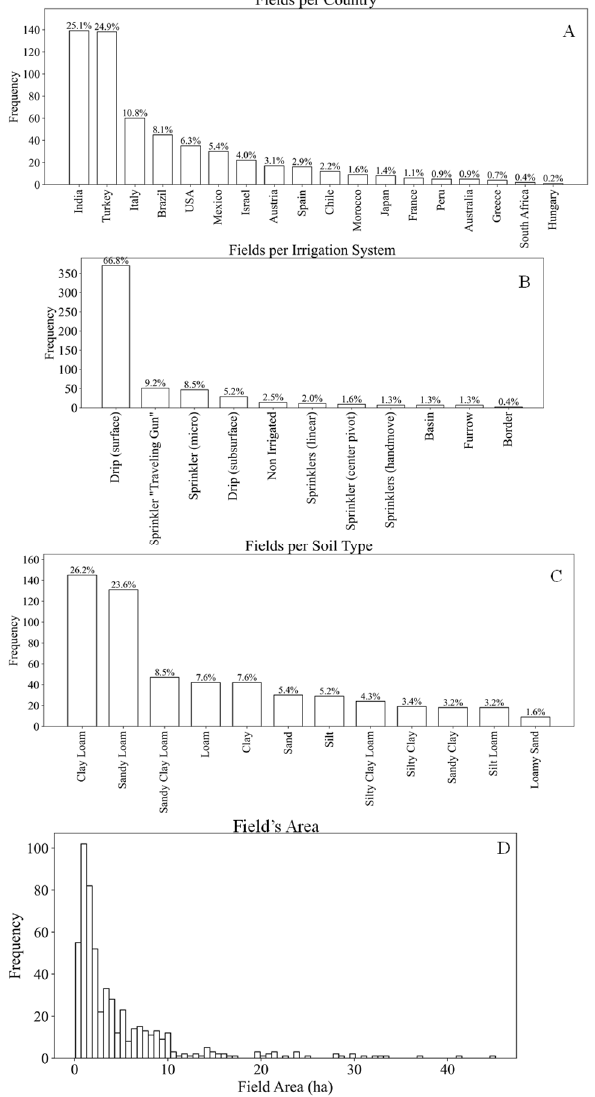
Figure 1. Countries ( A ), irrigation systems ( B ), soil types ( C ), and field areas ( D ) in the distribution of the fields used in this study.